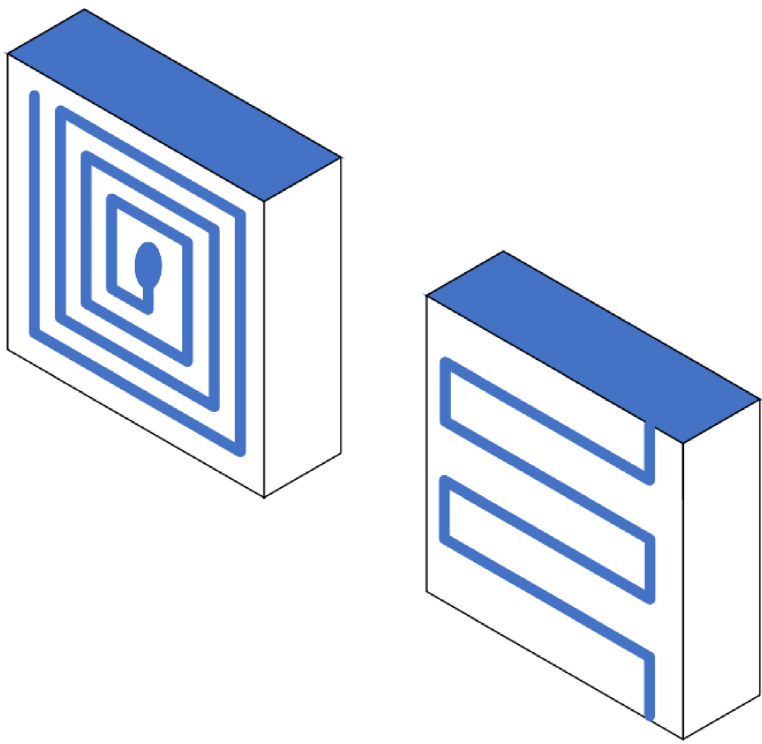
Fig. 12. Schematic diagram of negative index metamaterial